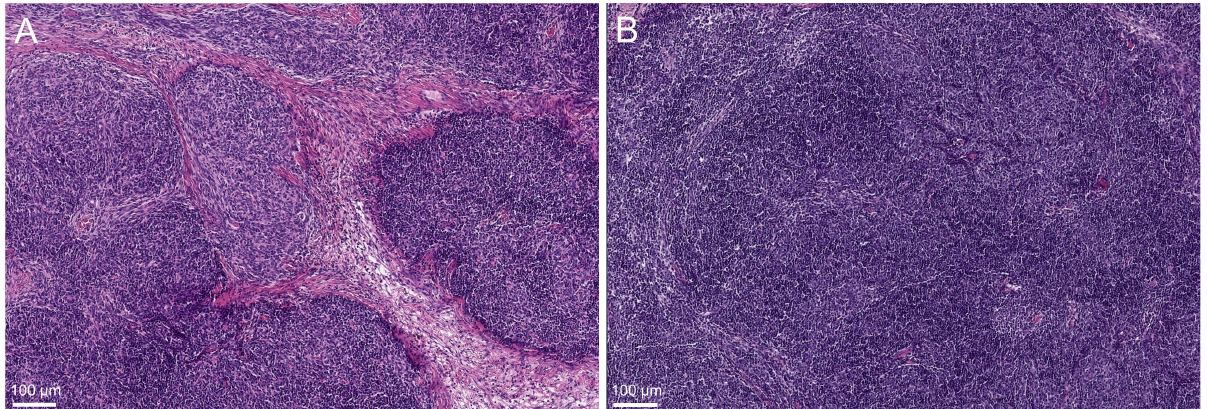
Figure 2. ( A ) Biphasic AB-thymoma with pure spindle cell-rich tumor areas (center) next to lymphocyte-rich type B-like areas (periphery) (hematoxylin and eosin staining). ( B ) Monophasic AB-thymoma with a high lymphocyte content among spindle tumor cells throughout the tumor (hematoxylin and eosin staining).